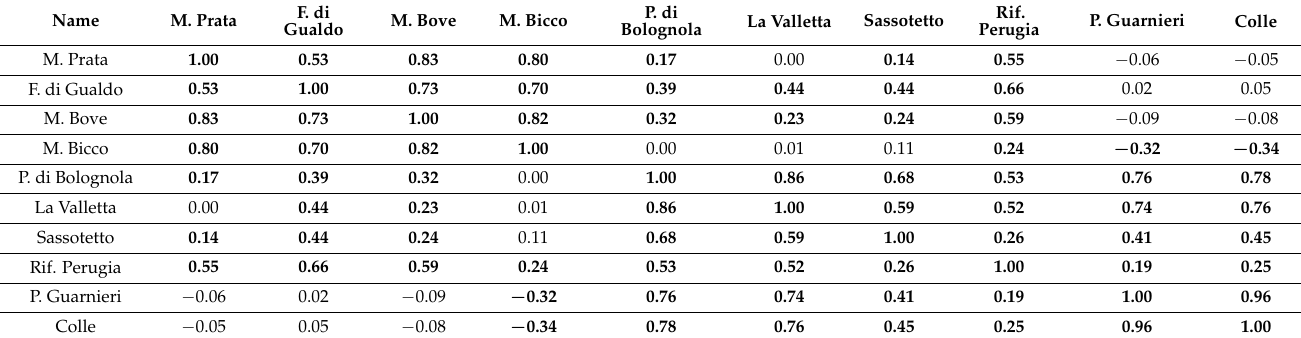
Table 2. Correlation matrix performed with Pearson’s method between weather stations for daily snow depth data; the stations with a significant 95% correlation between them are in bold.